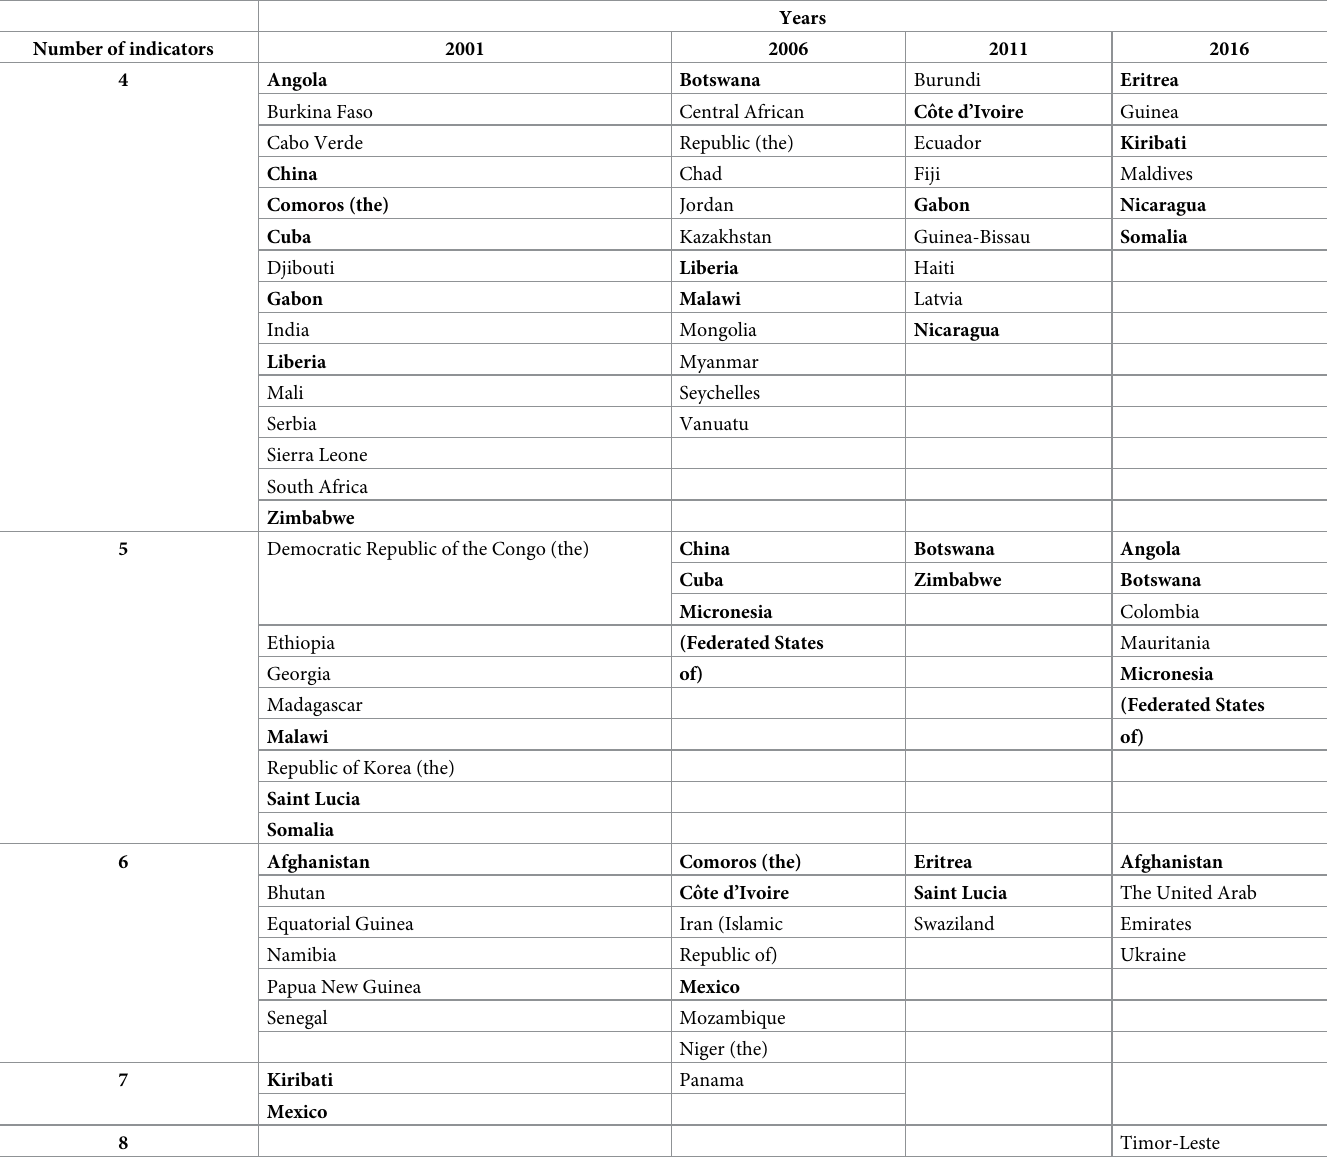
Table 2. List of countries that had four or more denominator accuracy and consistency indicators flagged.